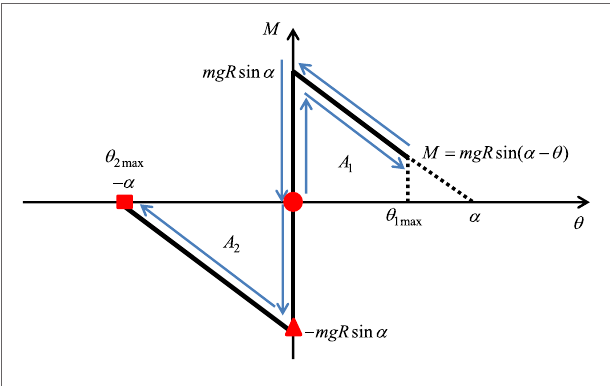
FigUre 6 | Moment-rotation relation for rocking response of rigid block and limit of overturning